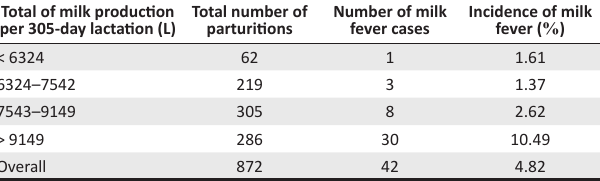
TABLE 5: Incidence of milk fever according to milk yield in Holstein cows. Total of milk production Total number of per 305-day lactation (L) parturitions